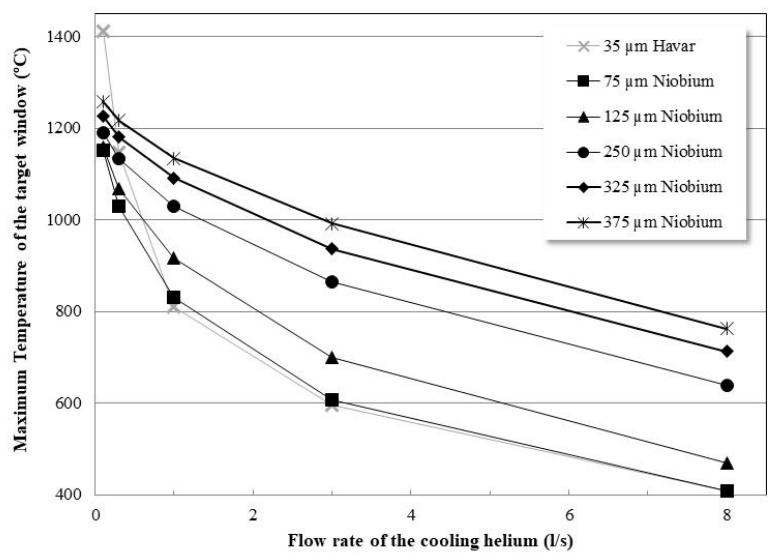
Figure 26. Maximum temperatures of the target window as a function of the flow rate of the cooling helium, for different target windows.